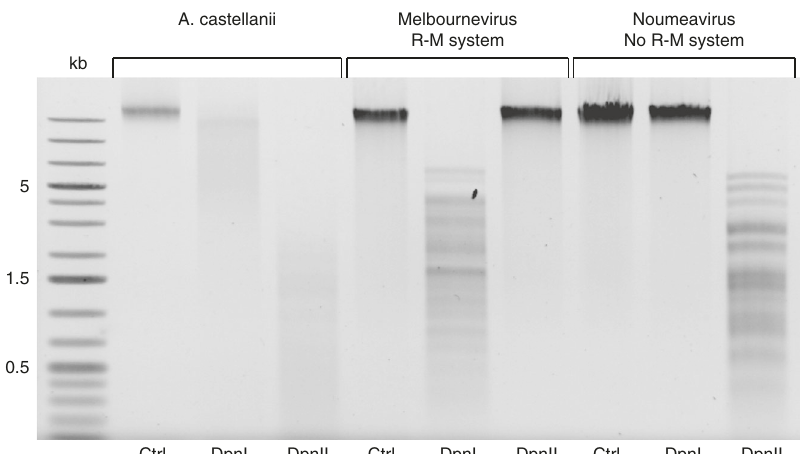
Fig. 3 Host and marseilleviruses DNA protection against GATC-targeting REases. Agarose gel electrophoresis analysis of A. castellanii , melbournevirus and noumeavirus DNA digested with GATC-targeting restriction enzymes. Restriction patterns using DpnI and DpnII enzymes are presented with control DNA. DpnI cleaves DNA at GATC sites containing N 6 -methyl-adenines and DpnII at GATC sites containing unmethylated adenines. This experiment was repeated twice with similar results.